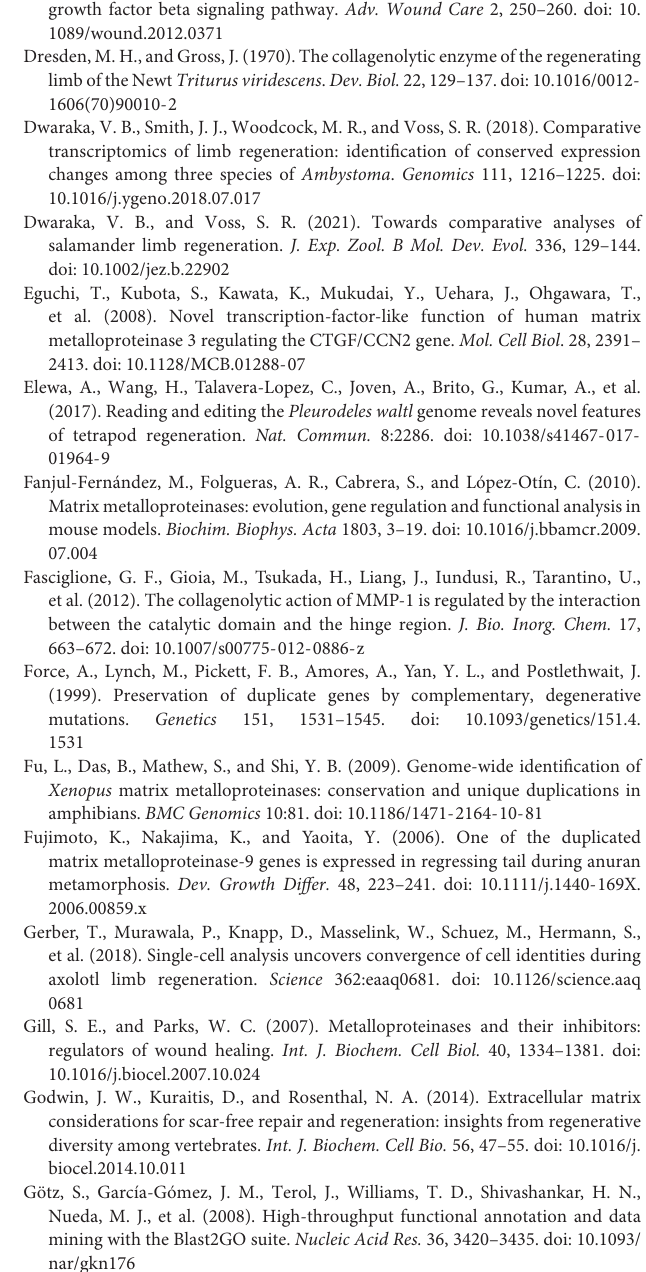
gray highlighted residues represent cysteine switch, furin recognition motif, and Zn + 2 binding domains, respectively. Note the COOH extension embedded within the domain. Supplementary File 8 | Multiple sequence alignment of all tetrapod transmembrane domain II MMP23B included in this study. Gray highlighted residues represent furin Zn + 2 binding domain. Note the lack of a cysteine switch and presence of the transmembrane domains, TXD, and ICAM domains.